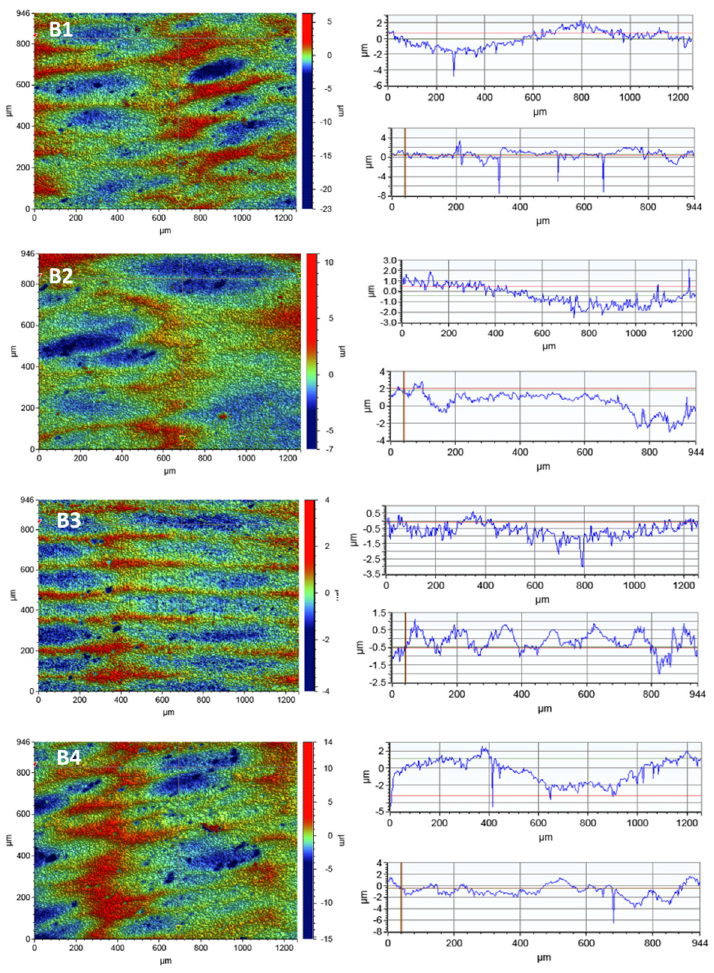
Figure 6. The surface microgeometry maps made for zirconia: ( B1 ) untreated control sample; ( B2 ) after irradiation with L1; ( B3 ) after irradiation with L2; ( B4 ) after irradiation with L3 and their height profiles made in the x-axis (upper profile) and y-axis (lower profile). Table 6. The roughness parameters for the zirconia samples before and after irradiation.